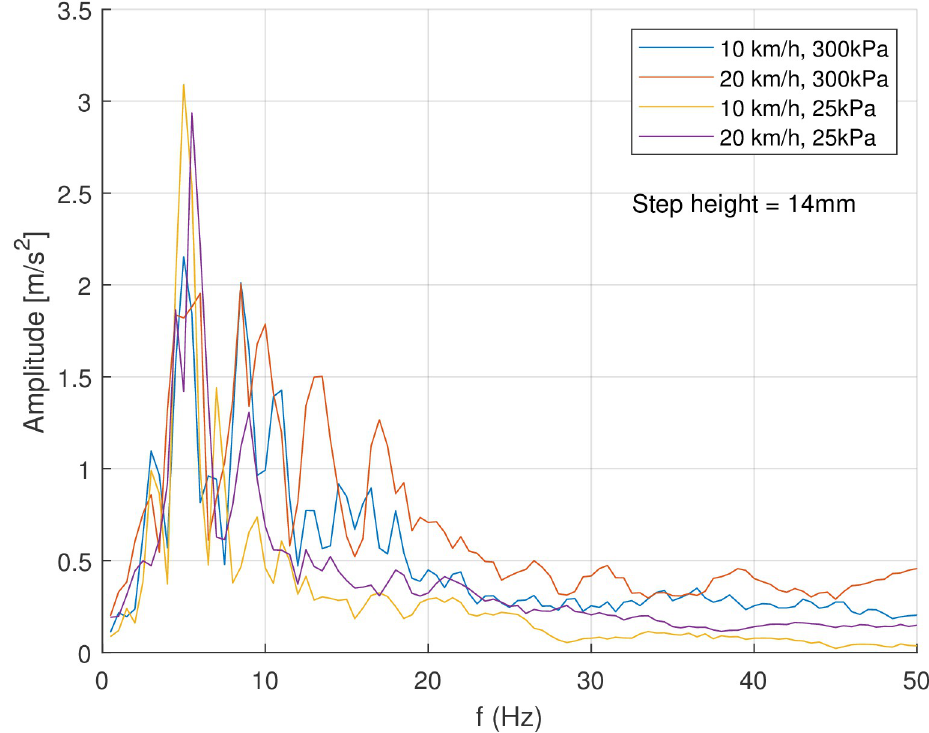
Fig 8. Single sided amplitude spectrum of the vertical acceleration a trailer over a step (14 mm). For each setting about ten test runs were combined by means of arithmetic amplitude mean